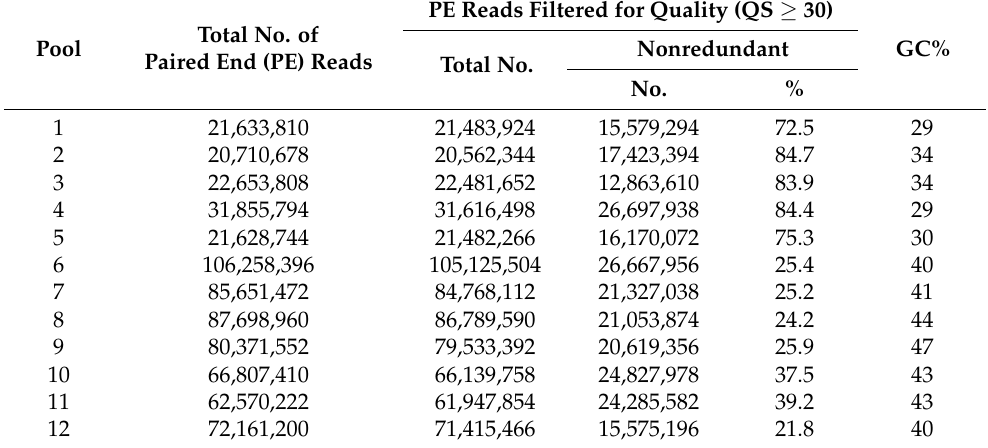
Table 2. Summary statistics of the sequencing